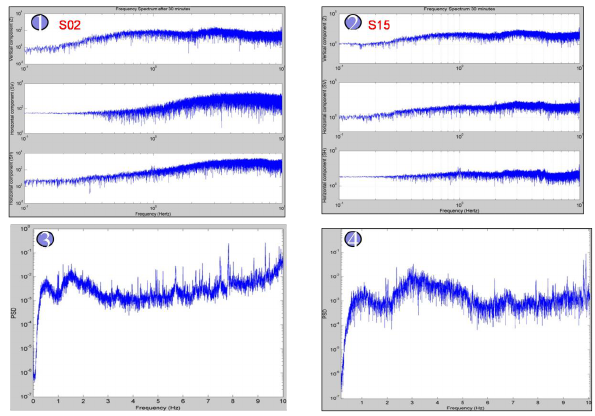
Figure 3. Frequency spectrum of stations S02 and S15 (1 and 2) with corresponding PSD (3 2 Fig. 3. Frequency spectrum of stations S02 and S15 (1 and 2) with and 4) 3 corresponding PSD (3 and